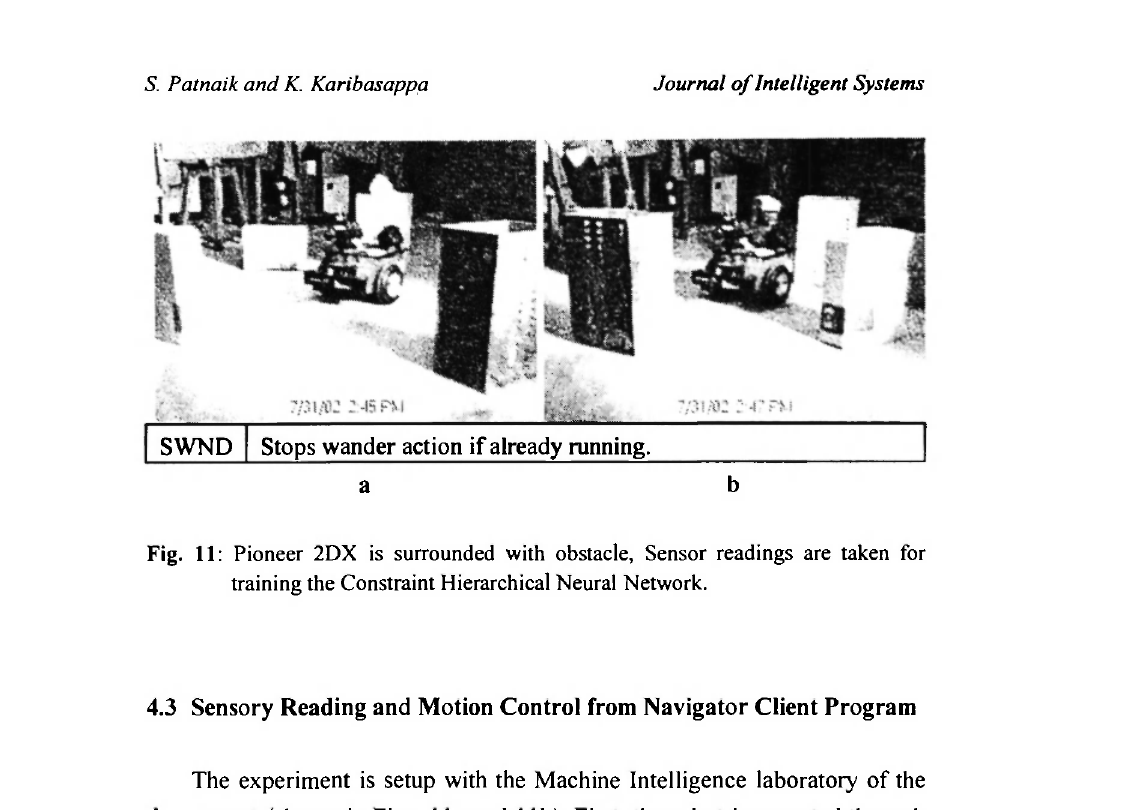
Fig. 11: Pioneer 2DX is surrounded with obstacle, Sensor readings are taken for training the Constraint Hierarchical Neural